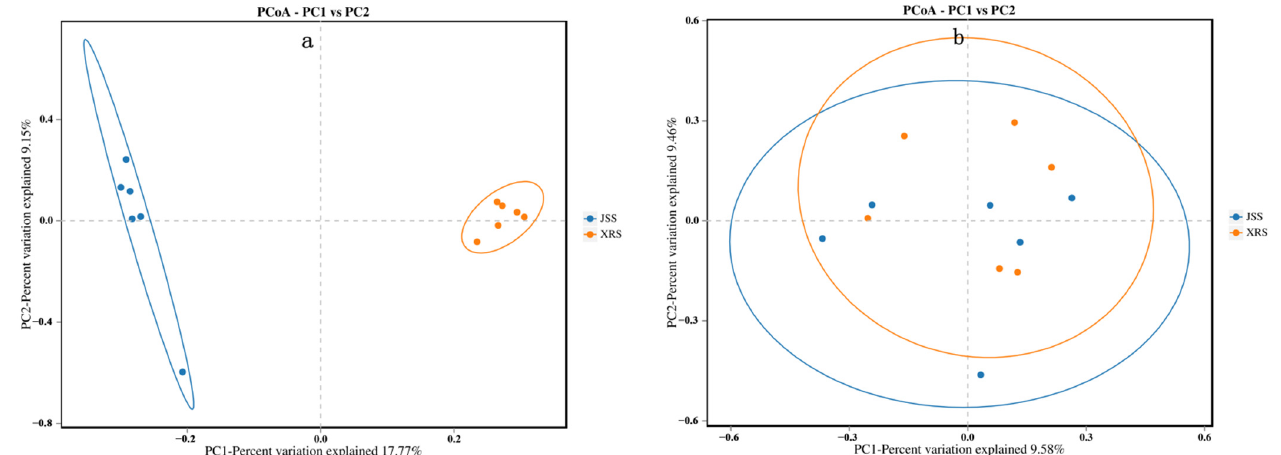
Figure 7. PCoA analysis from different groups, ( a ) bacterial community composition; ( b ) fungal community composition. Different colors represent different treatments. JSS: the bulk soil sample; XRS: soil of the P. sibiricum rhizosphere.